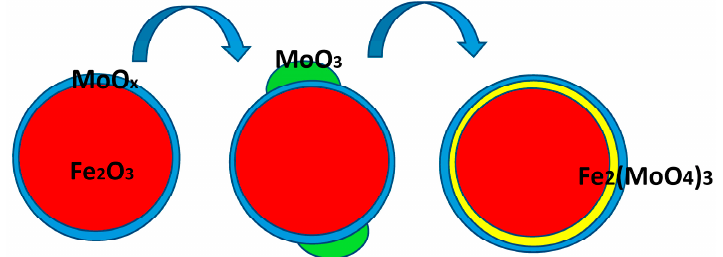
Figure 8. The evolution of the surface structure of the 3ML catalyst, as a function of annealing temperature. ( Left ) Structure at 120 °C. Fe 2 O 3 (red), with an amorphous layer of MoO x (blue); ( Middle ) Structure at 400 °C. MoO 3 nanocrystallites (green) at the surface of the catalysts, and the surface of MoO x present; ( Right ) Structure at 500 °C, MoO 3 nanoparticles have converted to Fe 2 (MoO 4 ) 3 (yellow), which is an underlayer to the topmost and active layer O h MoO x .